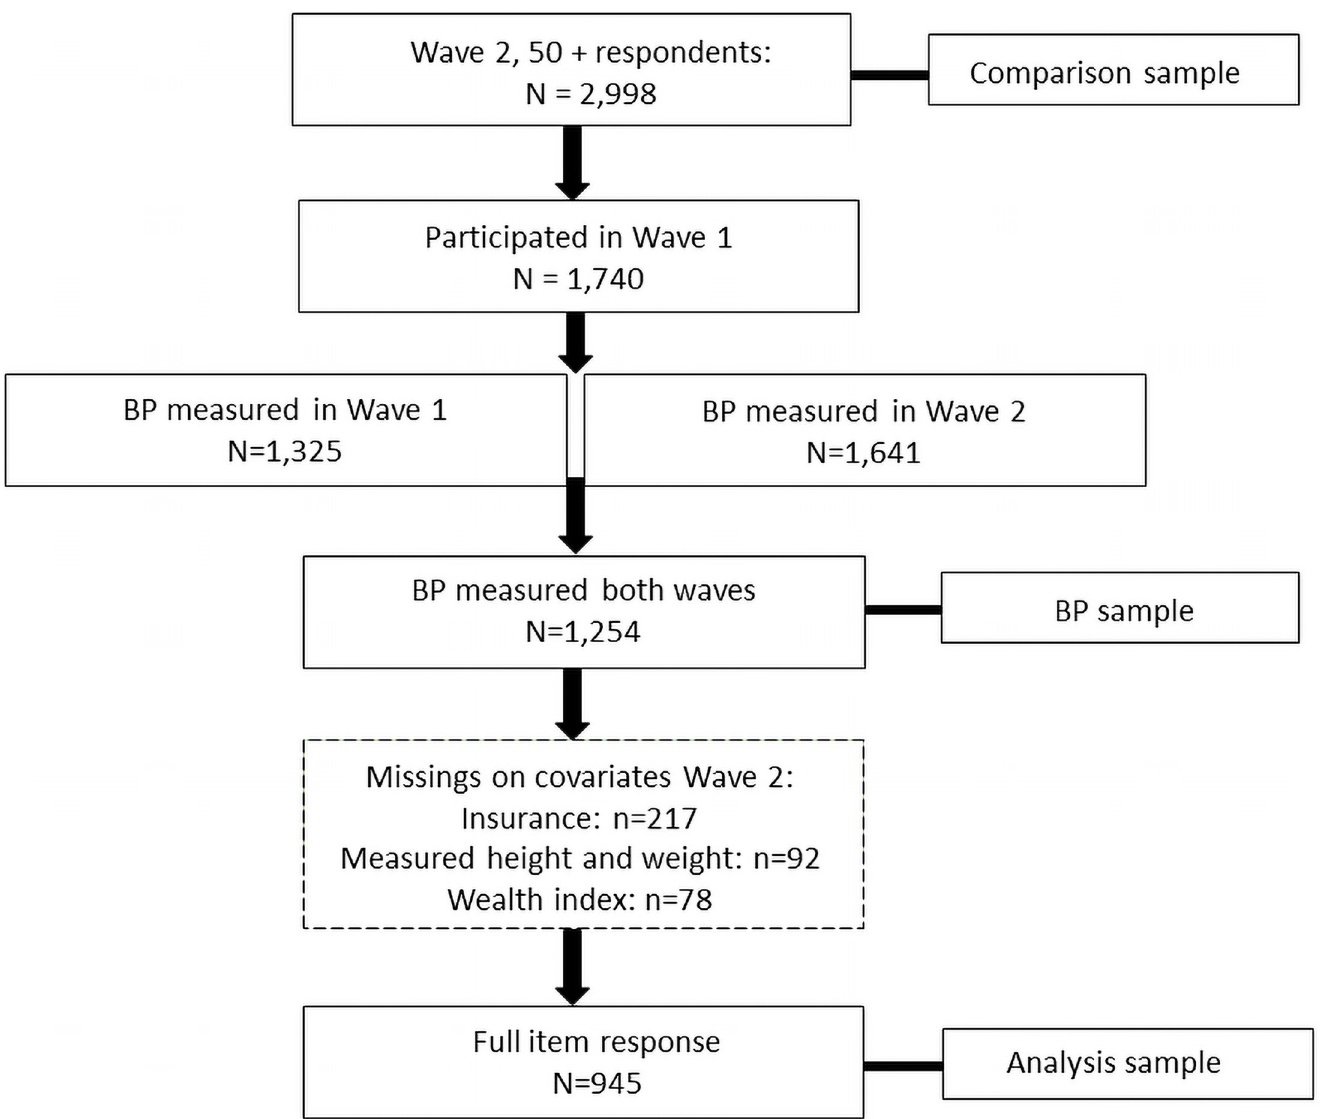
Fig 1. Participant flow chart. Notes : BP measured indicates that BP was measured and hypertension diagnosis and treatment were reported, allowing hypertension status to be established.